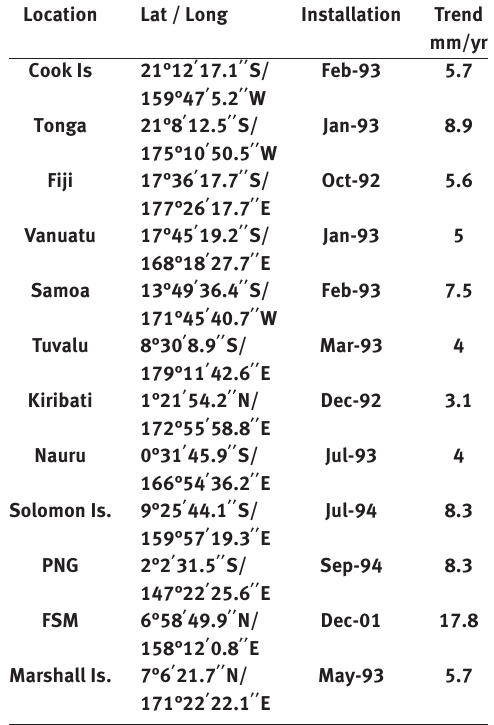
Table 2. Recent short-term sea level trends in The South Pacific Sea Level & Climate Monitoring Project area based upon SEAFRAME data through June, 2012 (from